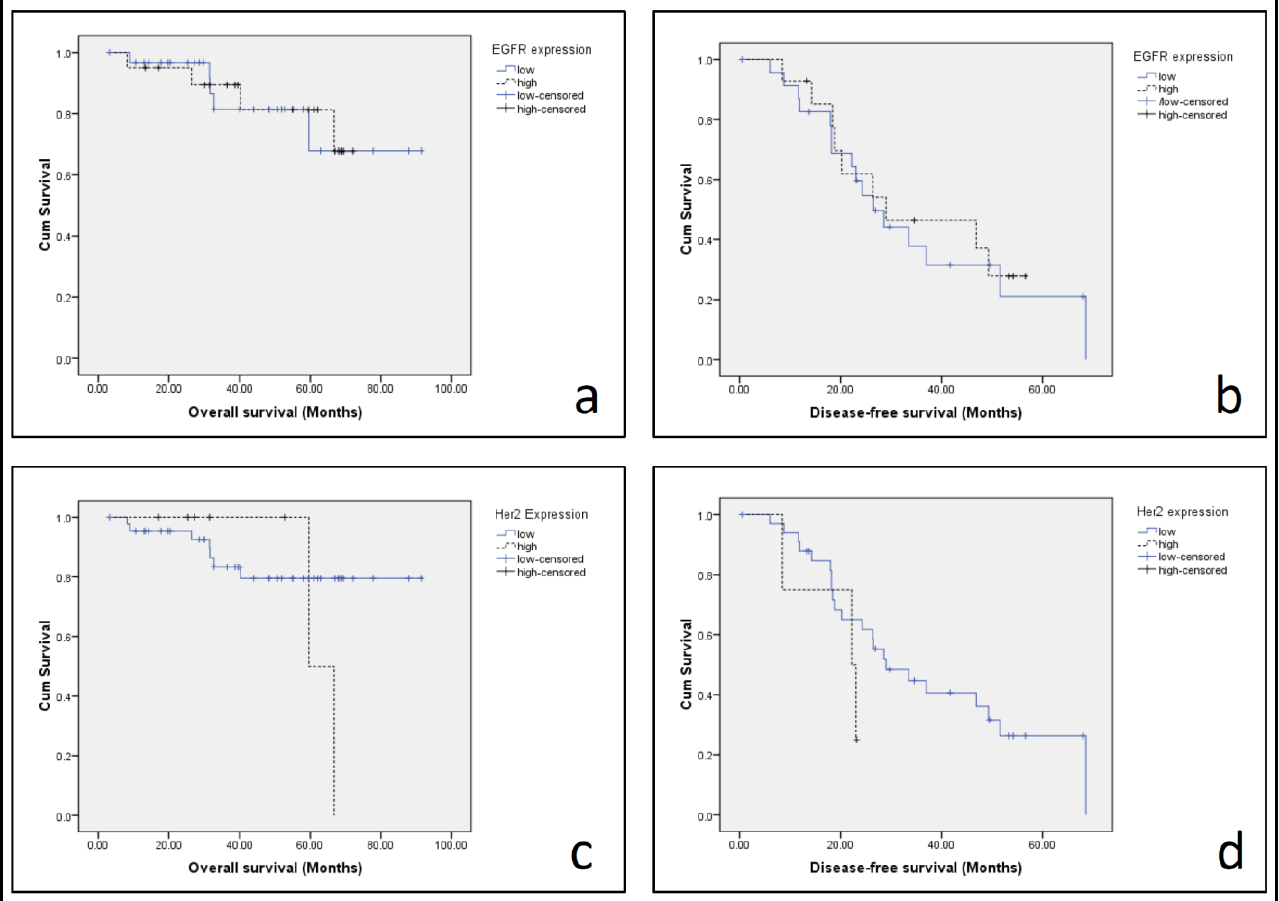
Figure 2: Kaplan-Meier survival curves [ a) Overall survival according to EGFR expression, b) Overall survival according to HER2 expression, c) Disease-free survival according to EGFR expression and d) Disease-free survival according to HER2